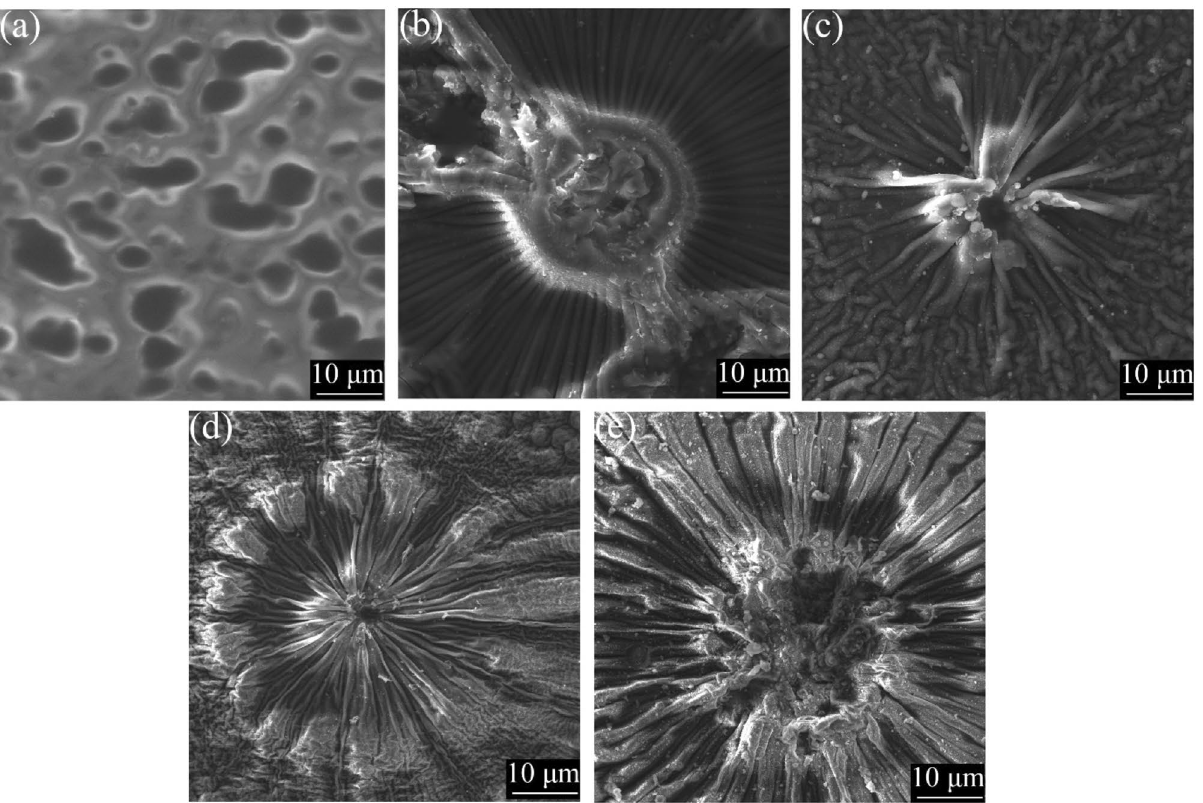
Figure 3. SEM images displaying the features of the films of m-Cresol created by plasma exposure durations of ( a ) 0.5 min, ( b ) 1 min, ( c ) 2 min, ( d ) 3 min, and ( e ) 4 min, on the Si substrate.